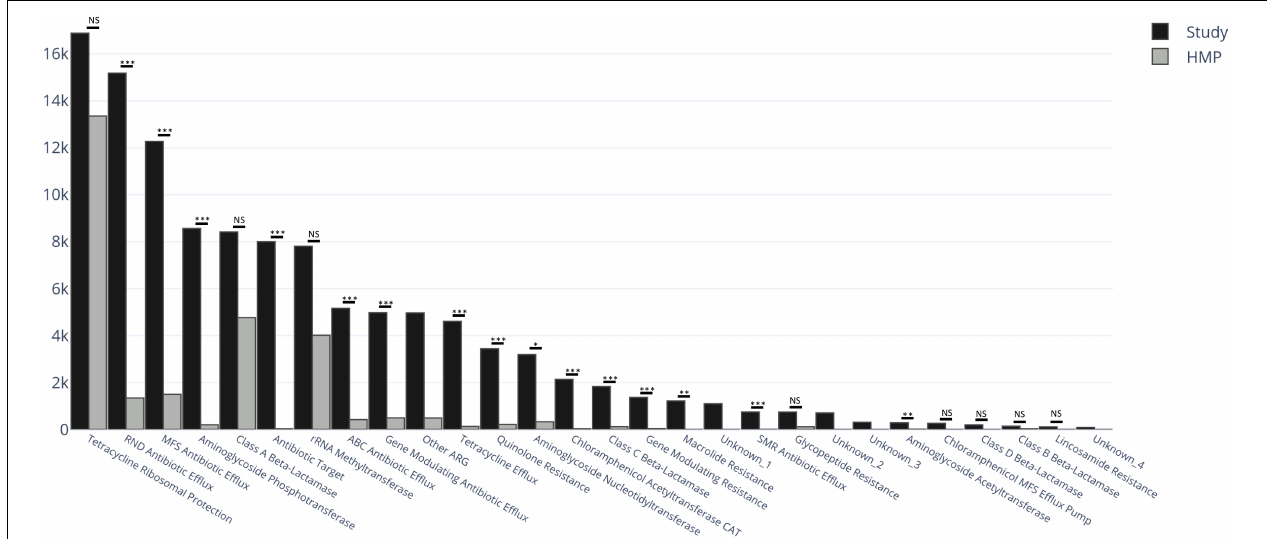
FIGURE 3 | Total abundance of AR genes (RPKM) within AR gene superclasses among the 82 subjects in the study cohort (black) and 82 healthy subjects from the human microbiome project (HMP) (gray). Between-group differences in the distribution of each AR gene superclass were estimated by comparing medians using Kruskal–Wallis Rank Sum test with subsequent Dunn’s correction for multiple comparisons. The categories Unknown_1, _2, _3 and _4, and Other ARG, were not considered in the analyses. RPKM, reads per kilobase of transcript per million mapped reads; ARG, antimicrobial resistance genes; NS, non-significant ( P > 0.05); ∗ P = 0.03 ∗∗ P = 0.002 ∗∗∗ P <